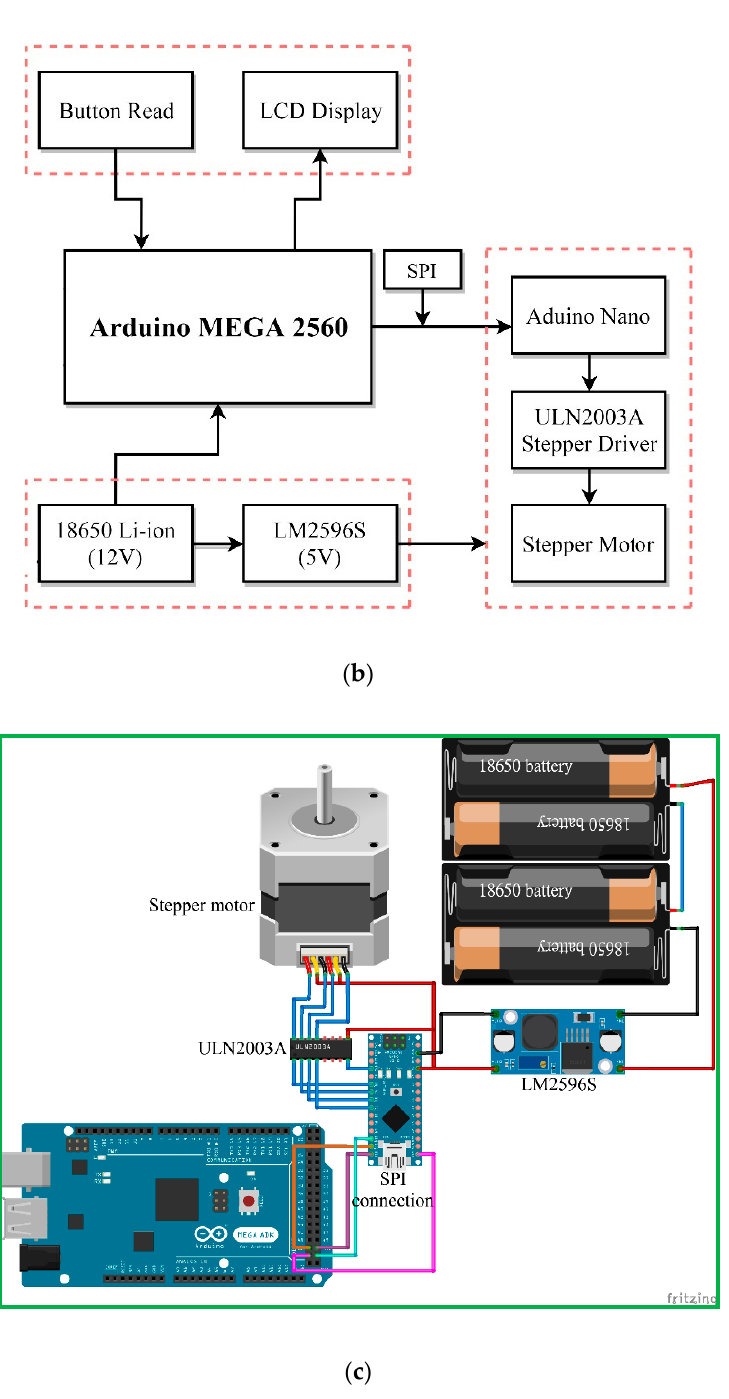
Figure 6. ( a ) A photograph of the homemade pumping unit composed of a stepper motor, a lead screw, a coupling, two linear bearings, and two guide rods. ( b ) A schematic diagram of the block diagram. ( c ) The circuit diagram of the syringe pump based on Arduino.